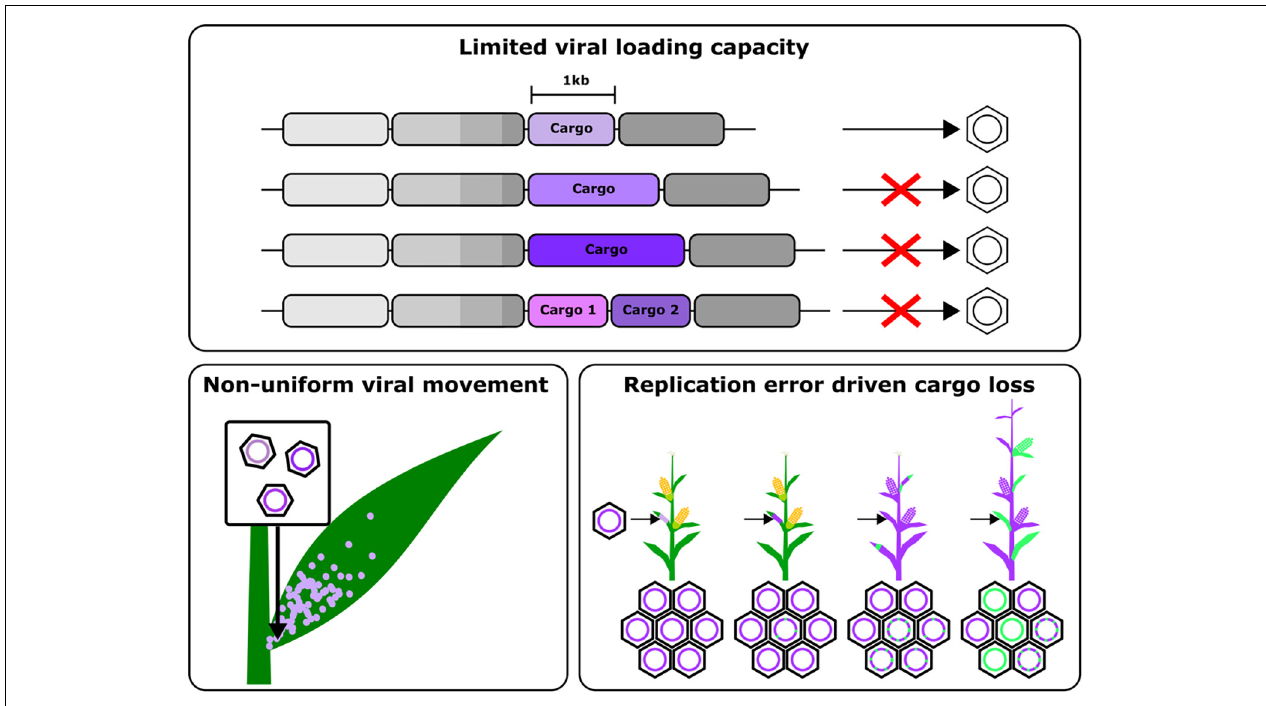
FIGURE 2 | Schematic summarizing the major challenges that need to overcome to engineer improved viral gene delivery tools, namely, a limited cargo capacity, non-uniform viral movement in plants and cargo loss due to error prone replication and